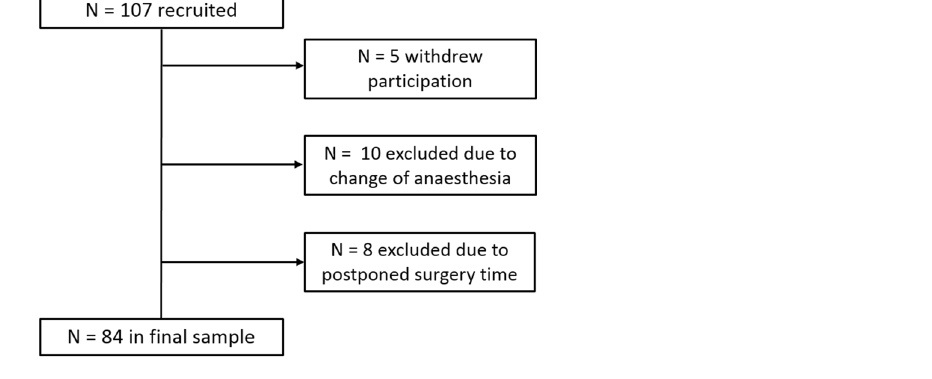
Figure 1. Flow chart of the